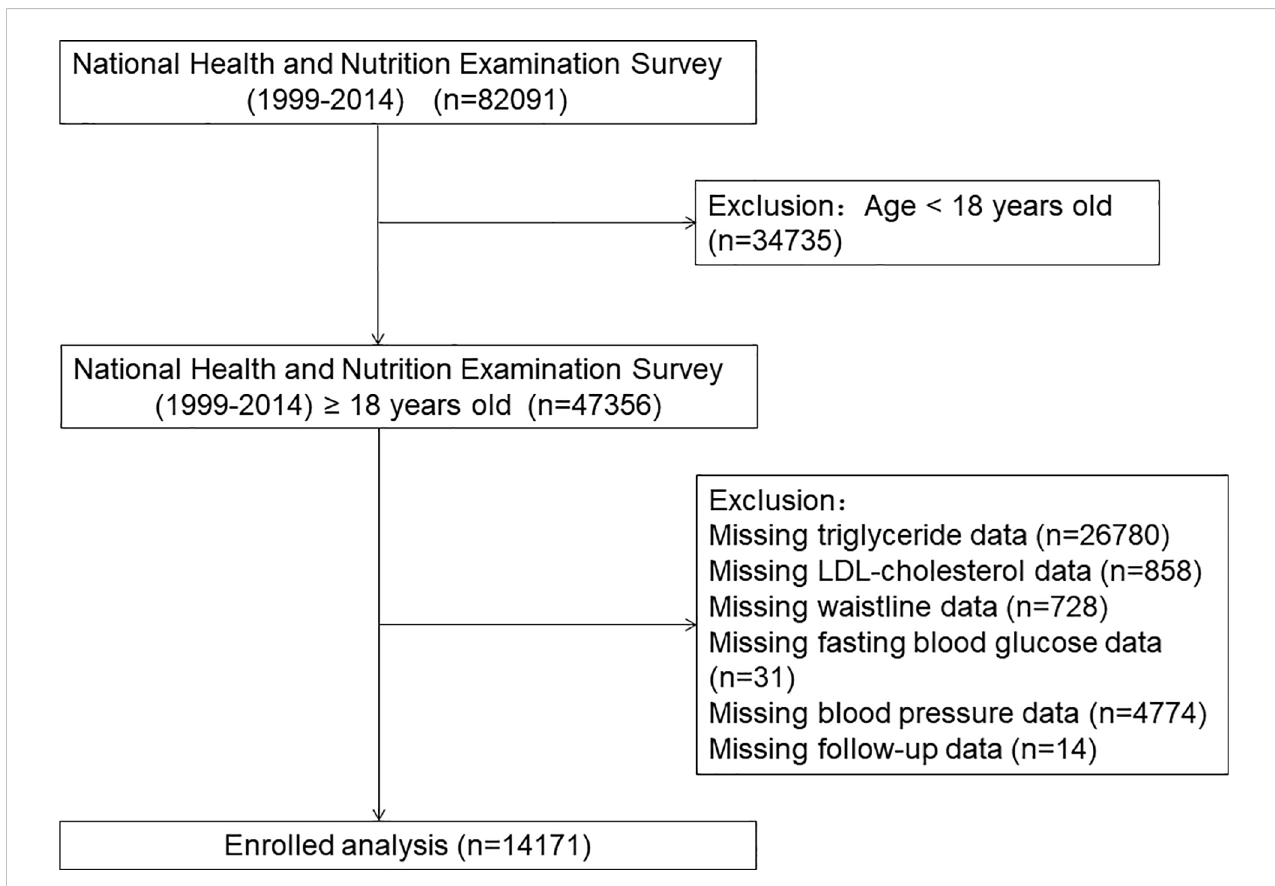
FIGURE 1 The research fl ow